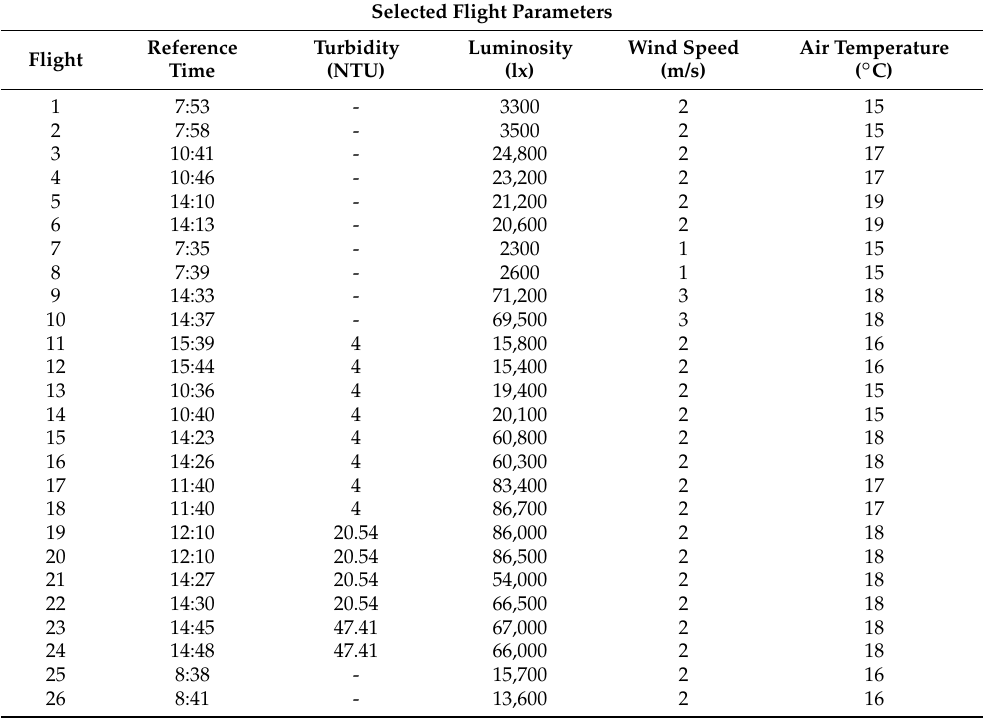
Table 5. Meteorological and water parameters during the flights. Selected Flight